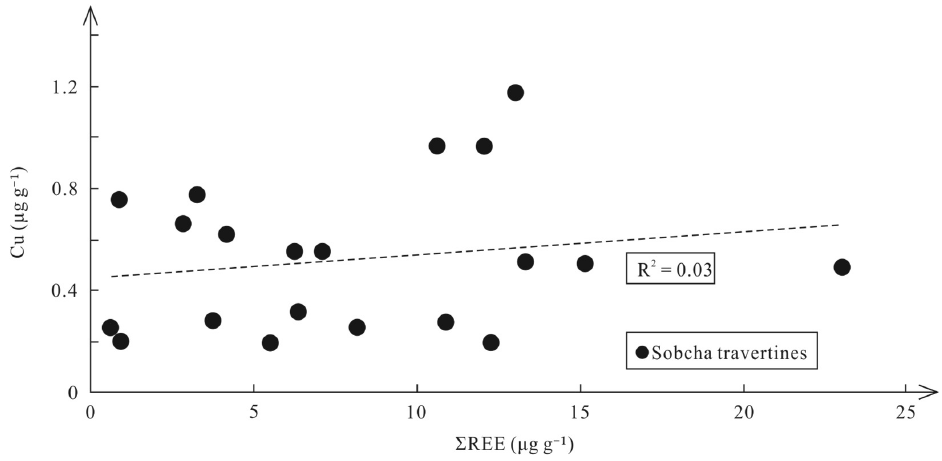
Figure 9. Bivariant graph of Cu and Σ REE of travertines from Sobcha. There are two striking REE characteristics of the Sobcha travertines: (1) MREE-en-